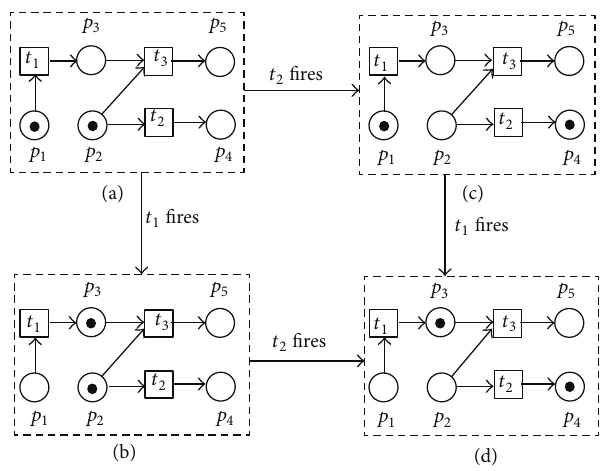
Figure 1: (a) A subnet system, (b) the subnet system obtained by firing the transition 𝑡 1 in Figure 1(a), (c) the subnet system obtained by firing the transition 𝑡 2 in Figure 1(a), and (d) the subnet system obtained by concurrently firing the transitions 𝑡 1 and 𝑡 2 in Figure